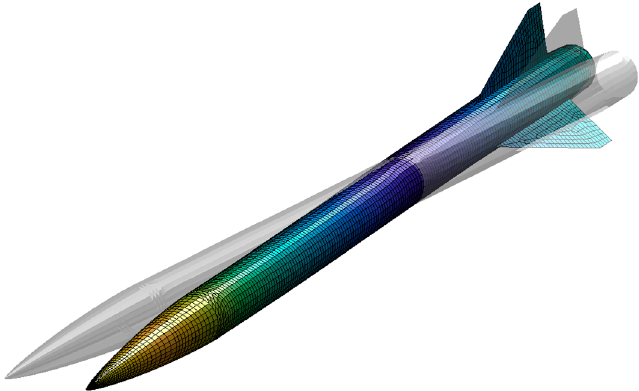
Figure 36. Representation of deflected rocket at a scale factor of 50.